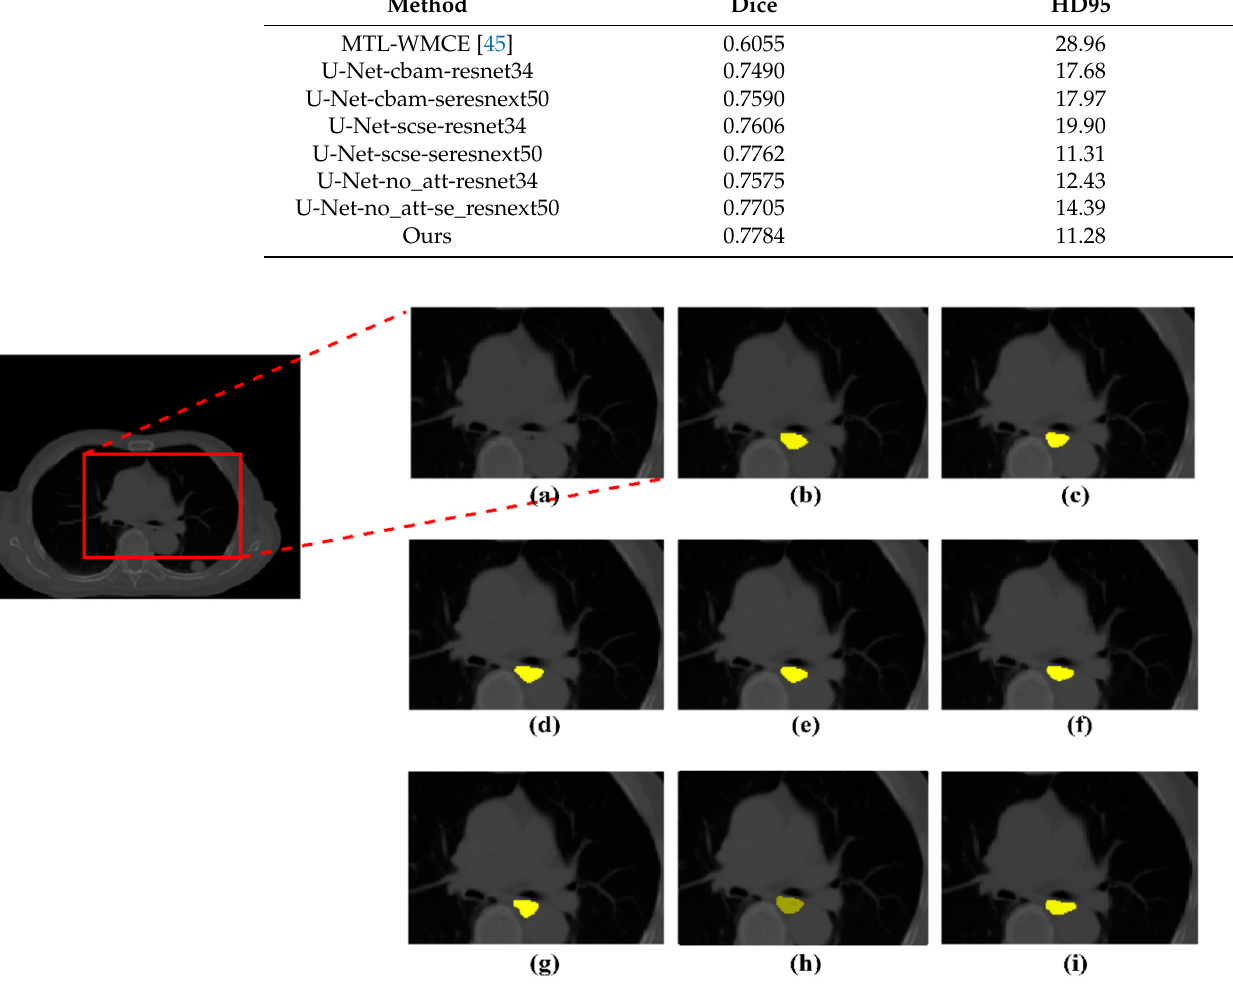
Figure 8. Visualization of esophagus segmentation results from validation set. The yellow area indicates the segmented region. ( a ) Small 2D patch; ( b ) Result of U-Net-cbam-resnet34; ( c ) Result of U-Net-cbam-seresnext50; ( d ) Result of U-Net-scse-resnet34; ( e ) Result of U-Net-scse-seresnext50; ( f ) Result of U-Net-no_att-resnet34; ( g ) Result of U-Net-no_att-se_resnext50; ( h ) Result of our method; ( i ) Ground Truth. Table 2. Dice score and HD95 score of esophagus segmentation comparison between our proposed method with others in StructSeg 2019 training set.